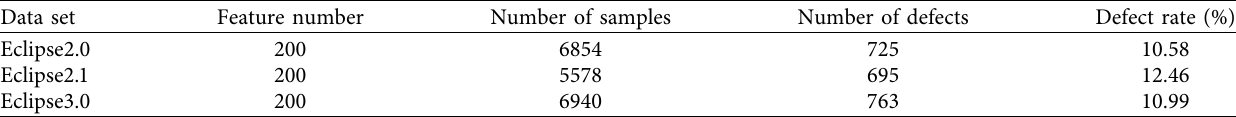
Table 1: Statistical information of Eclipse defect data set files granularity.